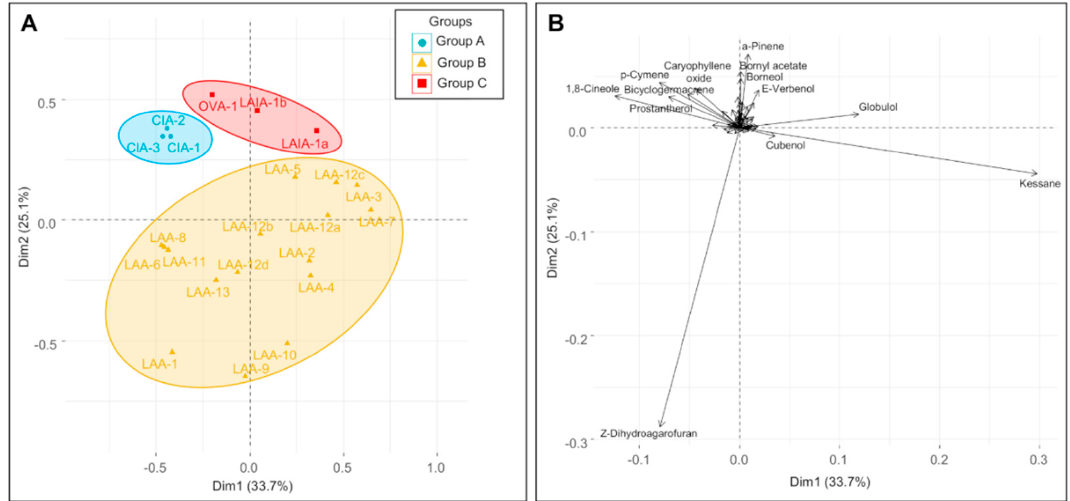
Figure 3. Dendrogram of chemical data of essential oils from species affiliated with P. ovalifolia and P. rotundifolia . BNM = P. sp. Barren Mountain, LAA = P. lanceolata , BEM = P. sp. Blue Mountains, CIA = P. cineolifera , ULN = P. sp. Ulan, COA = P. cotinifolia , OVA = P. ovalifolia (actual), and ROA = P. rotundifolia (actual).